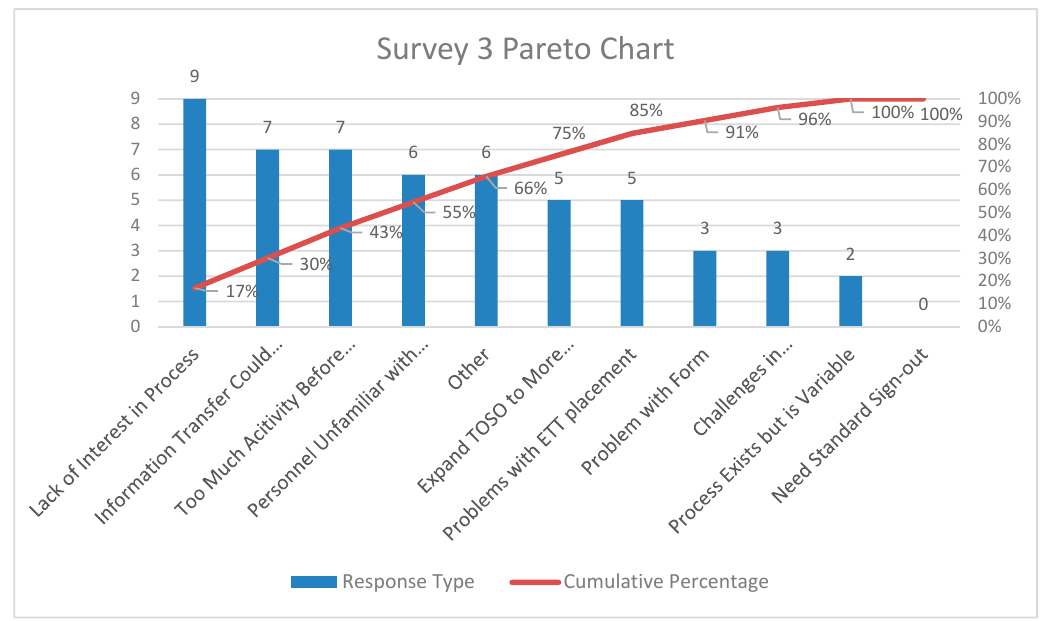
Figure 5. Pareto chart for comments from providers—Survey 3 ( > 2 years post-implementation survey).